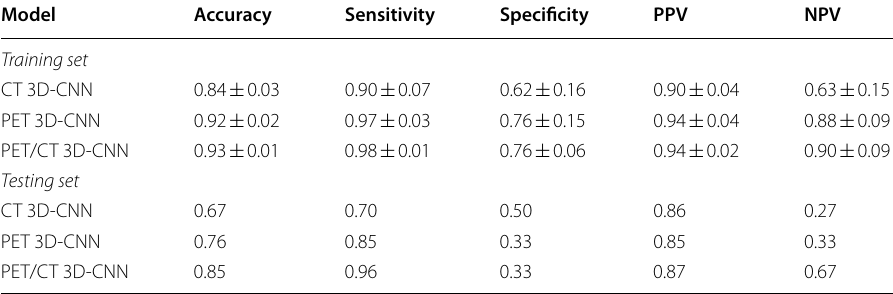
The results in the table are expressed as mean